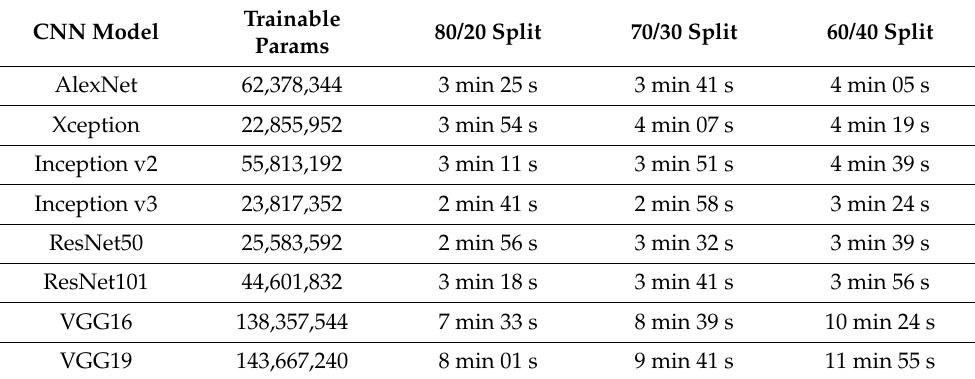
Table 5. Comparison of Computational Time between